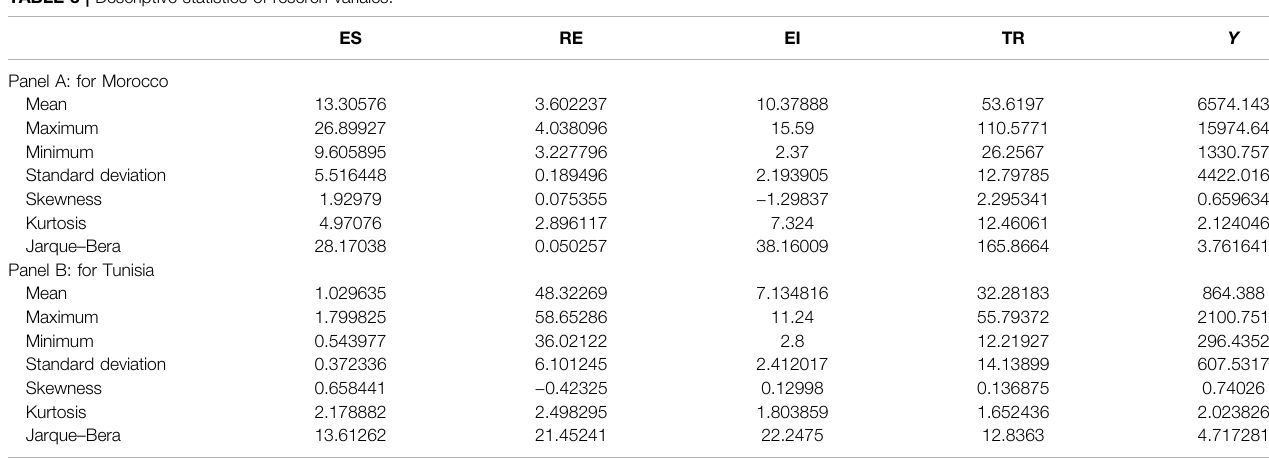
TABLE 3 | Descriptive statistics of reserch variales.